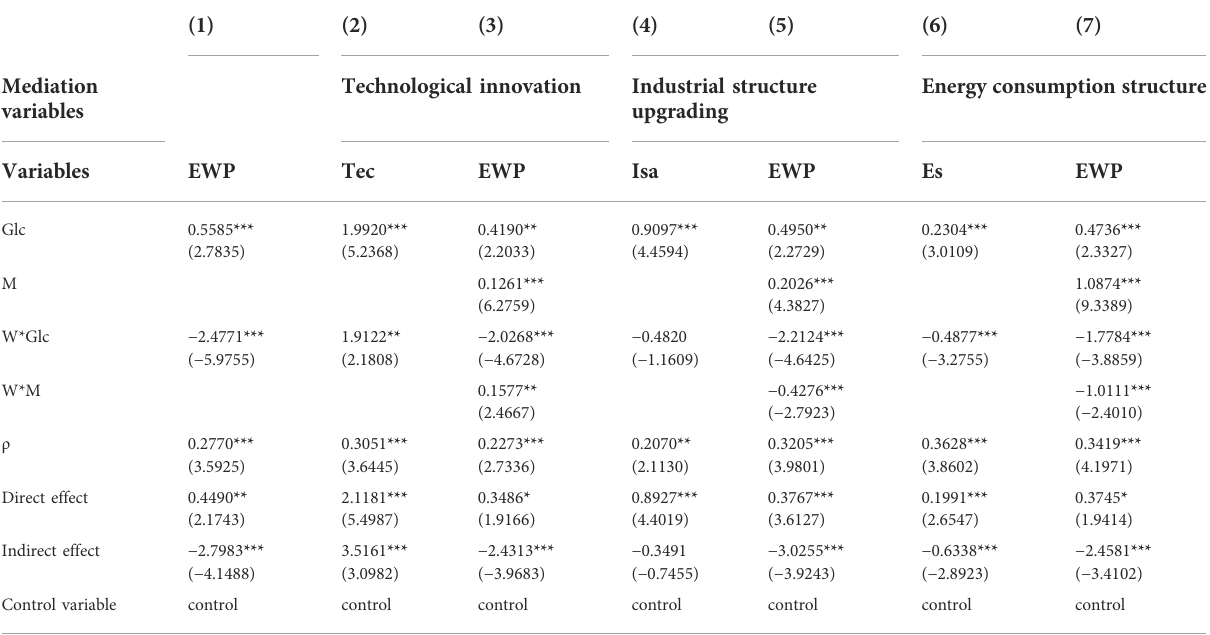
TABLE 6 The results of mediating effect model.